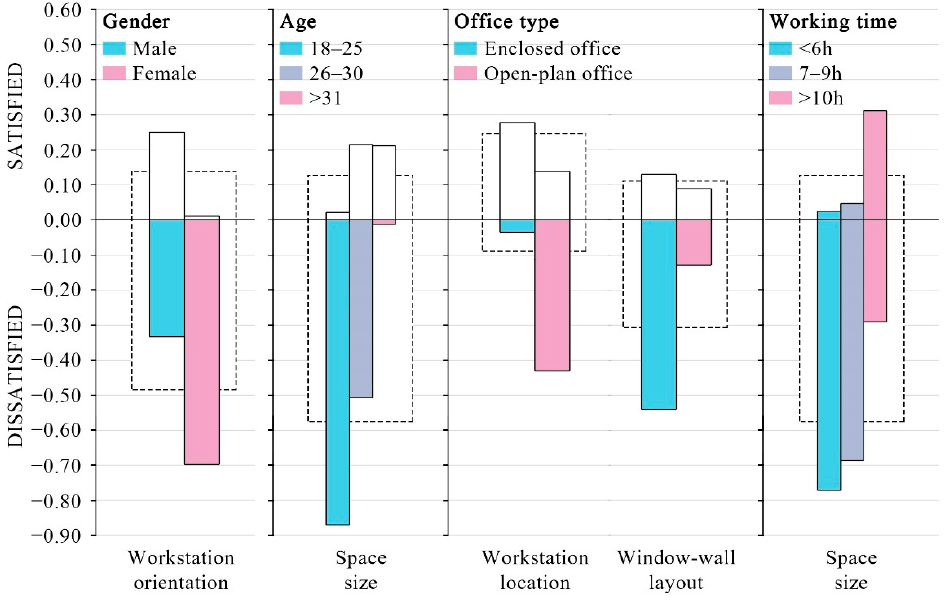
Figure 7. Significant relationships between factor regression coefficients and demographic characters.